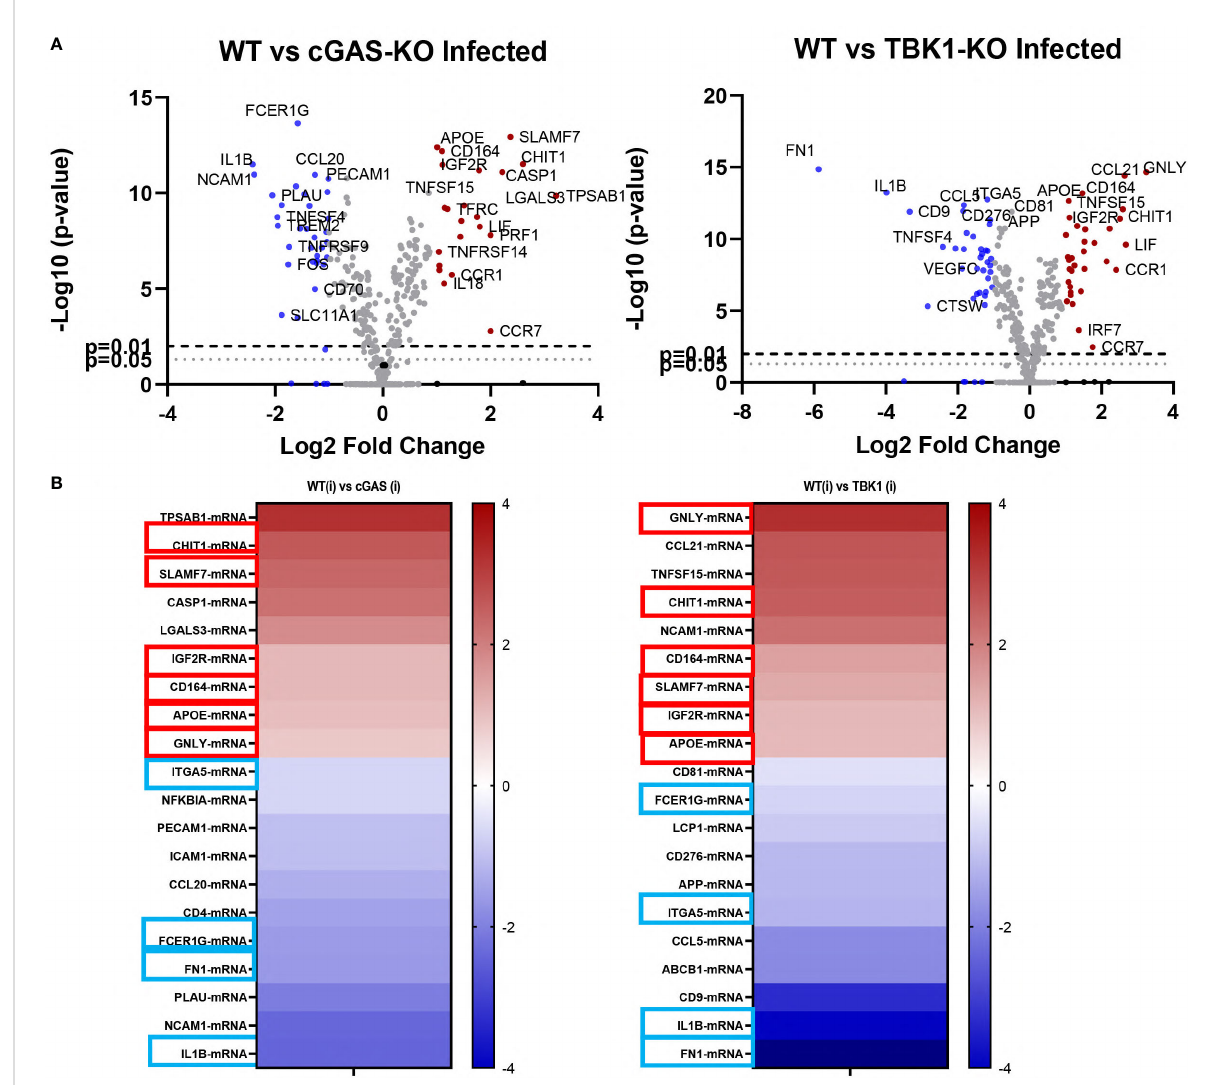
FIGURE 4 Differentially expressed genes in infected WT versus cGAS and TBK1 knockout cells. (A) Volcano plots of differentially expressed genes between L. major infected WT and knockout cell lines (n=3). Upregulated (fold change ≥ 2) and downregulated (fold change ≤ 2) genes are shown in red and blue, respectively. Dashed lines represent p=0.01 and dotted lines show p=0.05. The log2FC is plotted on the x-axis, and the negative log10FDR (adjusted p-value) is plotted on the y-axis. (B) Heatmaps showing the top 10 most up- or down-regulated genes in the infected knockout cells with respect to infected WT controls. Six of the shared upregulated genes and 4 of the shared downregulated genes are enclosed in boxes (red boxes, upregulated; blue boxes, downregulated). Statistical analysis for differentially expressed genes were performed using nSolver Analysis software (v4, NanoString Technologies, Inc., U.S.A.) and nCounter ® Advanced Analysis Software (v2, NanoString Technologies, Inc.,